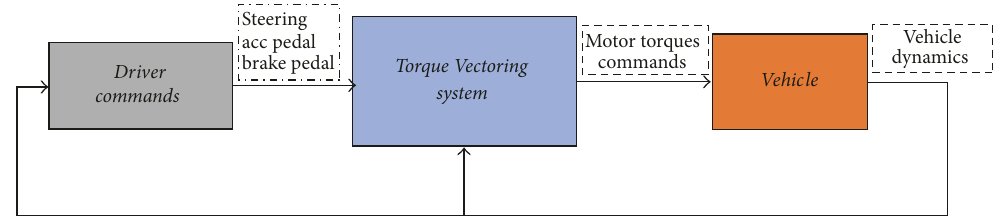
Figure 6: General test framework, based on Dynacar [36, 37].